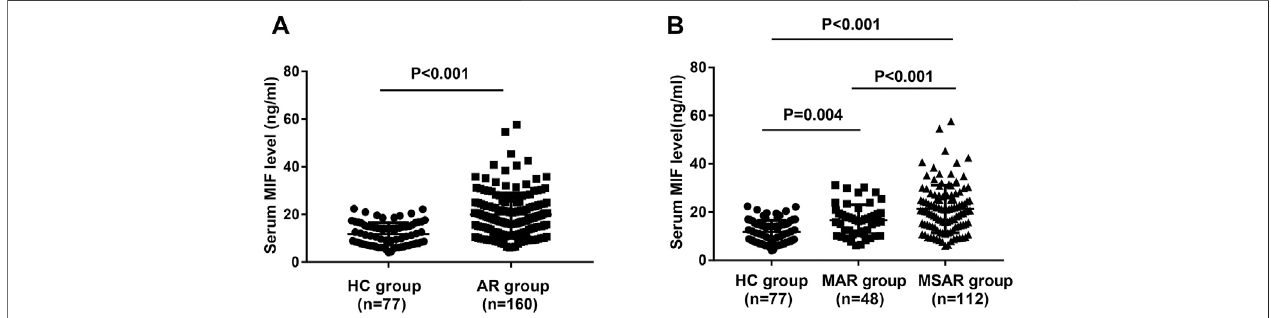
FIGURE1| ComparisonofserumMIFconcentrationsbetweenHDM-inducedARpatientsandHCs. (A) MIFlevelsweresigni fi cantlyincreasedintheARgroupthan in the HC group. (B) Serum MIF levels were markedly elevated in the MSAR group than in the MAR group and HC group. MIF, macrophage migration inhibitory factor; HDM, house dust mite; AR, allergic rhinitis; HC, healthy control; MAR, mild allergic rhinitis; MSAR, moderate – severe allergic rhinitis.